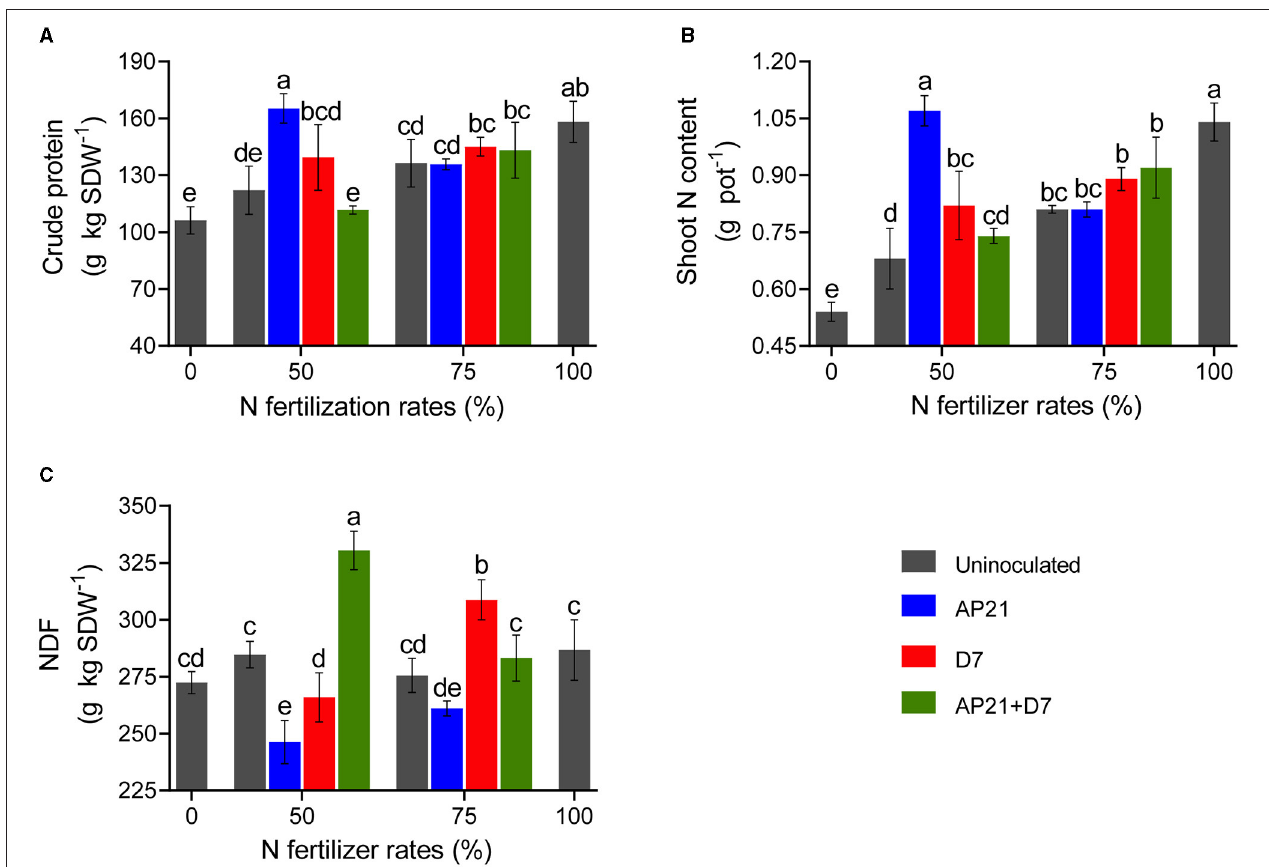
FIGURE 2 | Effect of the inoculation on bromatological parameters: crude protein (A) , shoot N content (B) , neutral detergent fiber (NDF) (C) . Error bars represent ± standard deviation. Different letters indicate significant differences based on Duncan’s test ( p < 0.05). Each value is the mean of three blocks with three replicates per